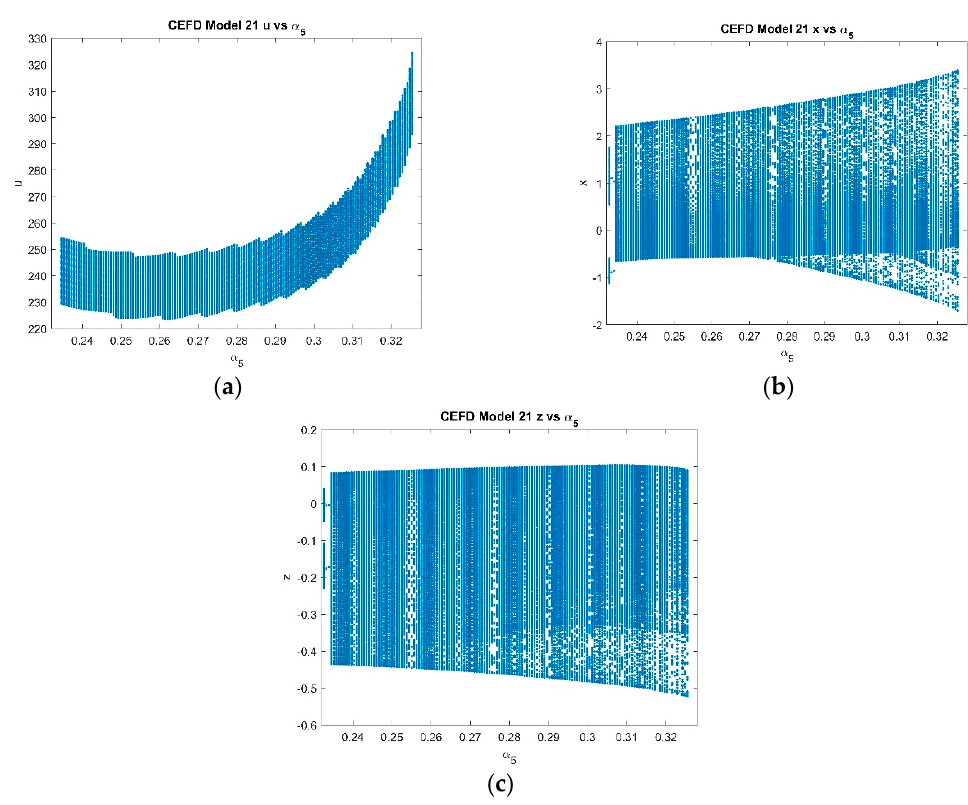
Figure 4. CEFD model (21); bifurcation of ( a ) 𝑢 ( b ) 𝑥 ( c ) 𝑧 versus 𝛼 (cid:2873) for ℎ = 0.002 .